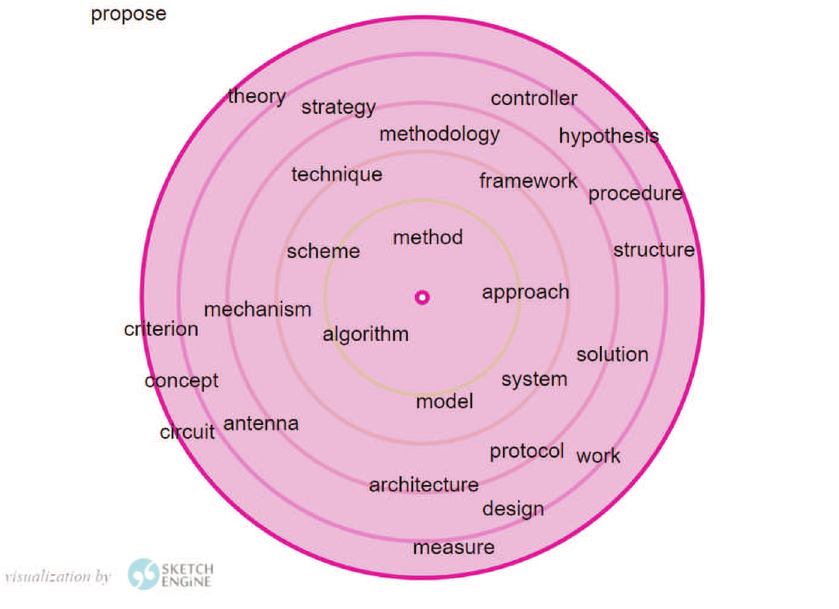
Figure 1. Objects of the verb propose as found in the DOAJ